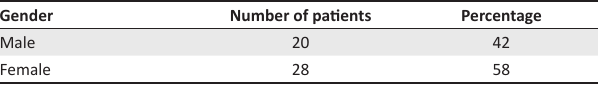
TABLE 3: Gender distribution as numbers and percentages of those patients with known demographic